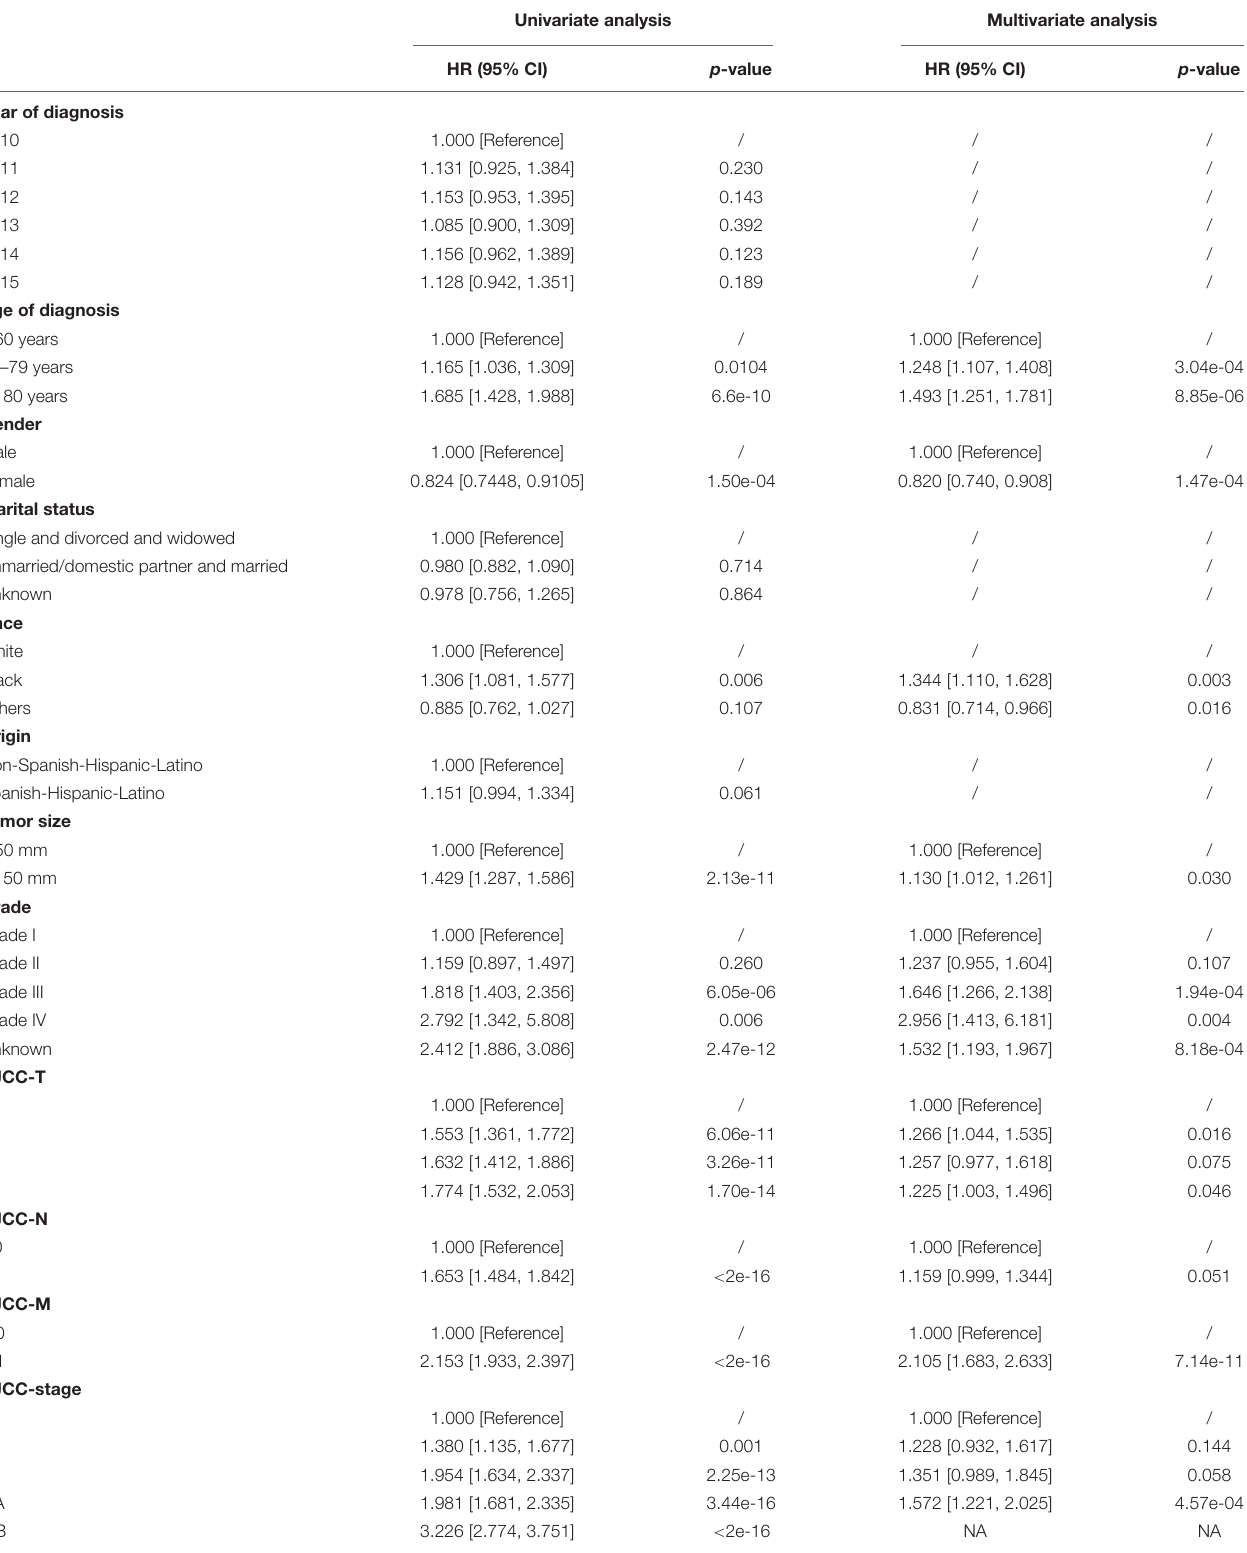
TABLE 2 | Univariate and multivariate regression analysis in the training dataset. Univariate analysis Multivariate